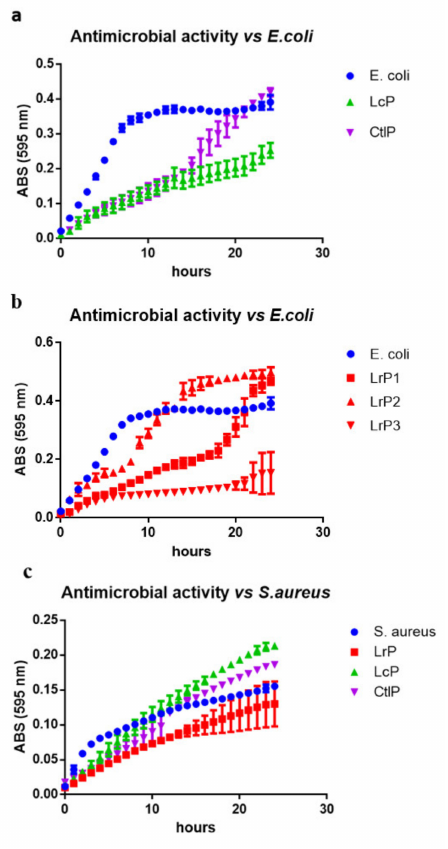
Figure 2. Antibacterial activity of the peptides from donkey milk inoculated with L. rhamnosus 17D10 (LrP), L. lactis subsp. cremoris 40FEL3 (LcP), and not inoculated (CtlP). The antibacterial activity was evaluated against E. coli and S. aureus clinical isolates as means of pathogen growth inhibition. ( a ) Antimicrobial activity of LcP and CtlP samples vs. E. coli ; ( b ) the three biological replicates of LrP samples vs. E. coli were reported individually due to their high variability; ( c ) antimicrobial activity of LrP, LcP, and CtlP samples vs. S. aureus